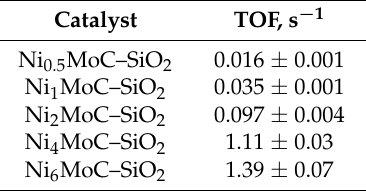
Table 9. TOF values for calcined and reduced Ni x MoC–SiO 2 (400/600) catalysts. Reaction conditions: T = 150 ◦ C, P = 6.0 MPa, m cat = 1.000 g, and furfural/isopropanol molar ratio equal to